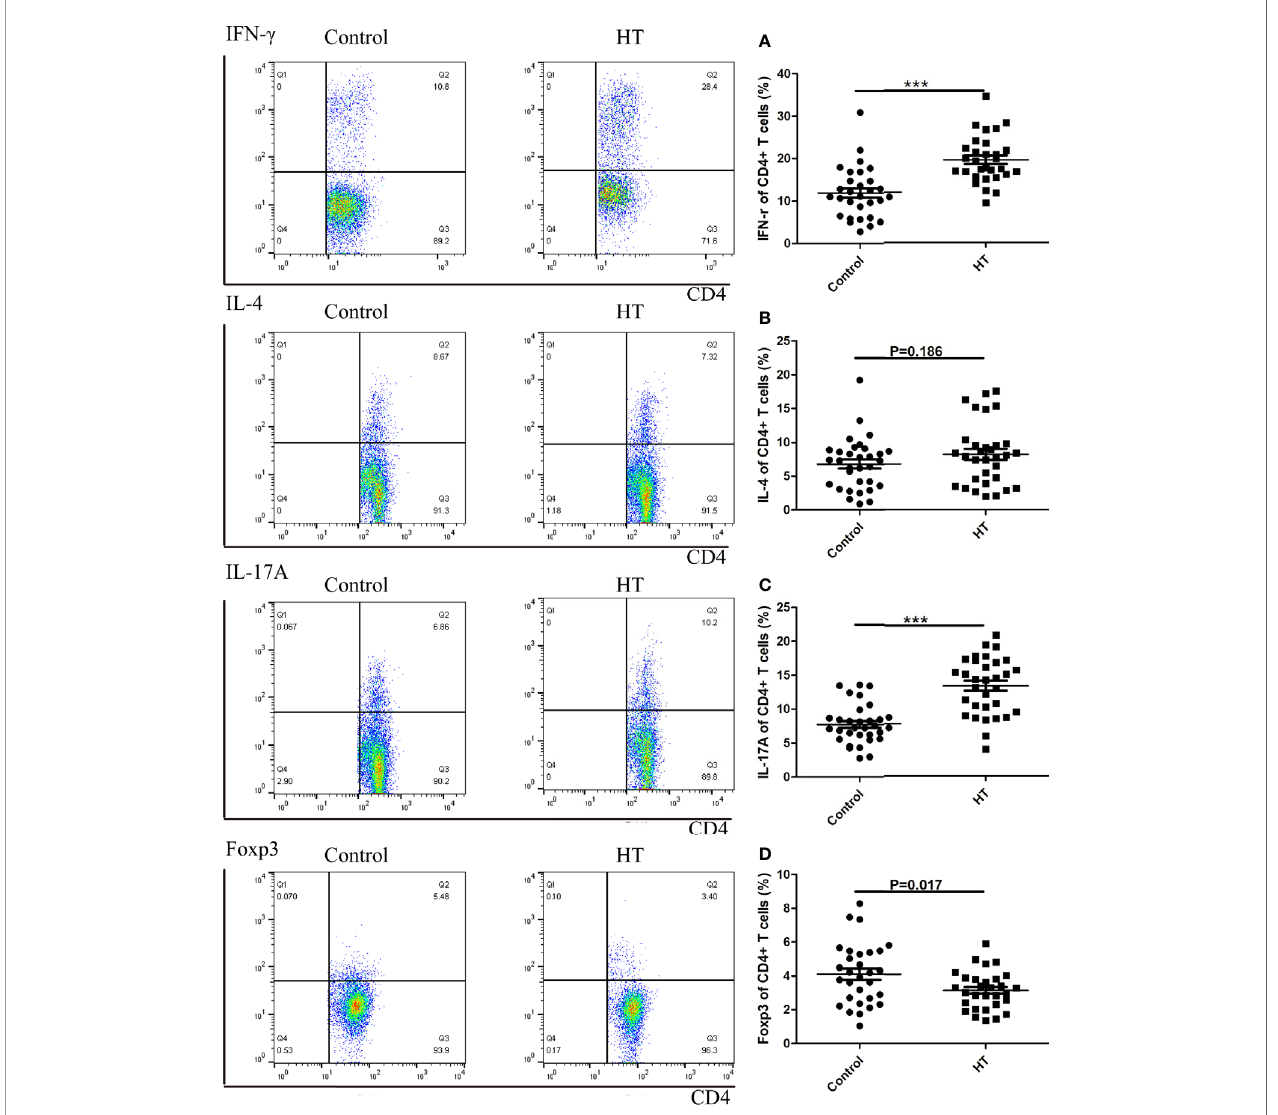
FIGURE 1 | The ratio of CD4+ T cells subtypes in HT patients and HC group determined by fl ow cytometry. A representative Flow sample is shown from each sample, and samples were run individually rather than pooled. Lymphocytes from HC and HT subjects were stimulated for 5 hours with CD3/CD28 and the ratio of subtypes in CD4+ T cells were measured by fl ow cytometry. The cell frequency of CD4+IFN g + (A) , CD4+IL4+ (B) , CD4+IL17A (C) and CD4+Foxp3+ (D) was determined. The frequency of T cell subsets was investigated in sixty donors (30 healthy and 30 HT donors). The mean cytokine values are compared using two-way ANOVA and the p values are indicated in the fi gure. (***P <